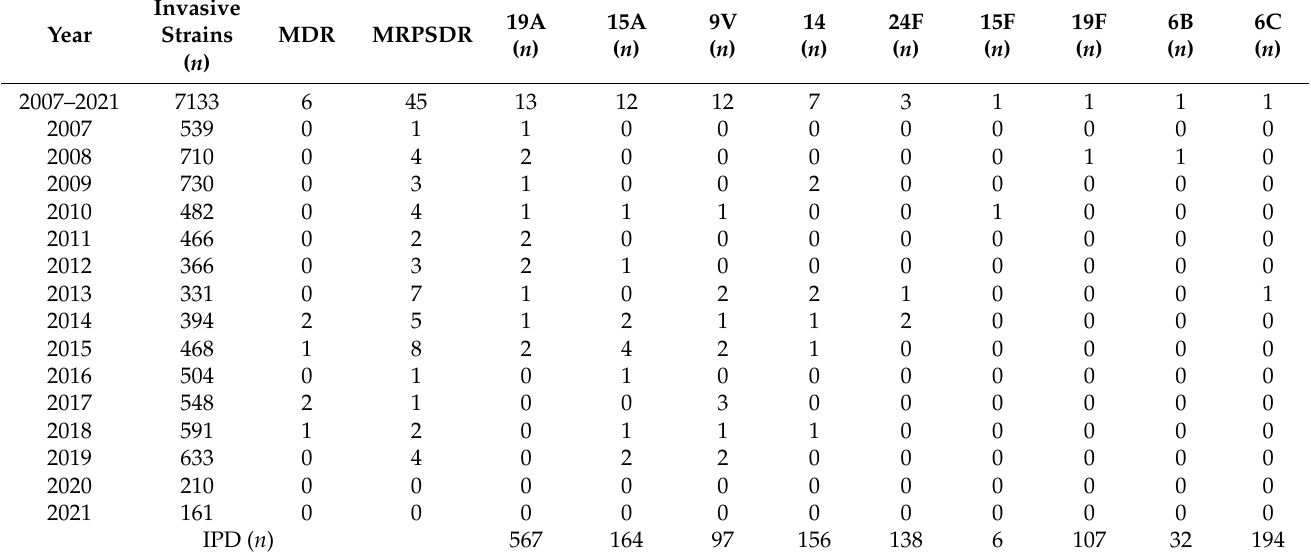
Table 4. Pneumococcal serotypes with multidrug-resistant at standard dosing regimen of penicillin and/or multidrug-resistant serotypes by year in the Madrid Region for the period 2007 to